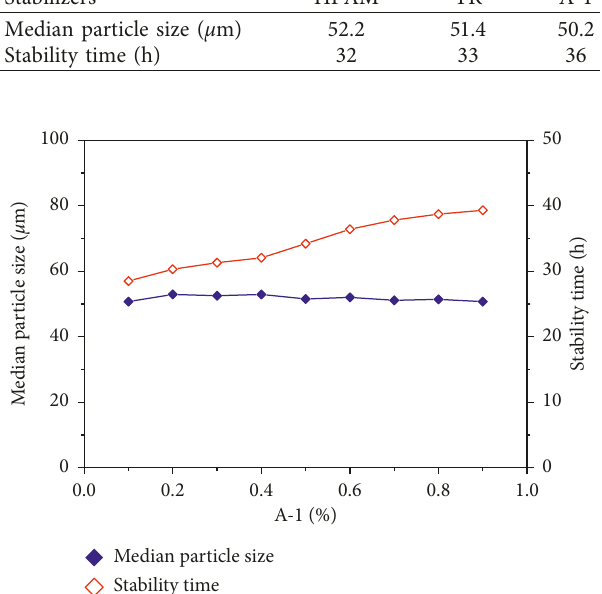
Figure 4: Influence of stabilizer A-1 dosage on particle size and stability time of the temporary plugging agent.